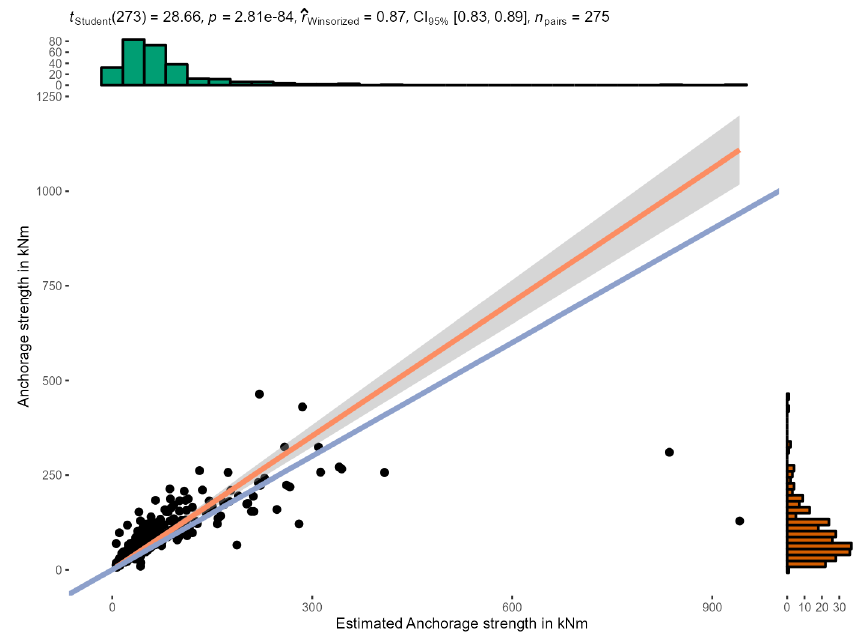
Figure 5. Estimated (Equation (3)) and measured anchorage strength (with four outliers beyond 1000 kNm removed). The blue line illustrates